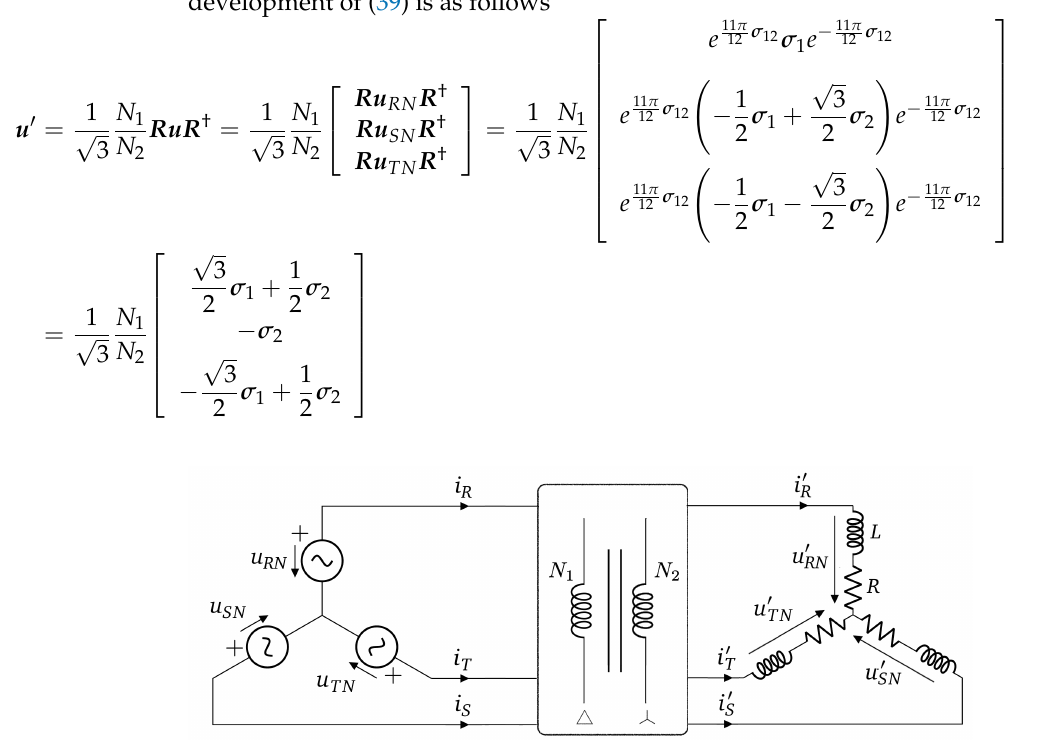
Figure 6. Three phase circuit with a Dy11 transformer with N 1 and N 2 windings for the primary and secondary,